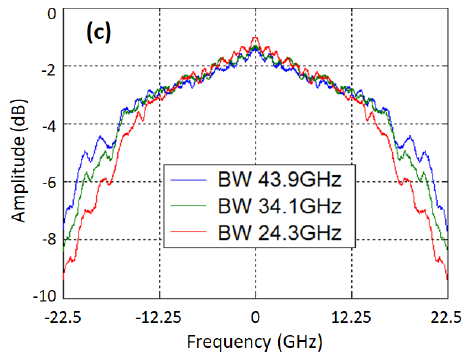
Figure 3. ( a ) Spectra from the analog-to-digital converter (ADC)’s raw outputs. ( b ) Spectra after applying the Savitzky-Golay filter. ( c ) Spectra of XI tributary under different bandwidths. Results are measured with 14-dB optical signal-to-noise ratio (OSNR).